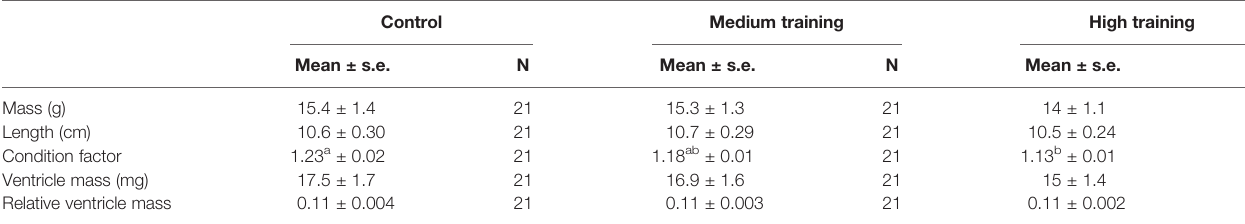
Different letters represent signi fi cant difference among the